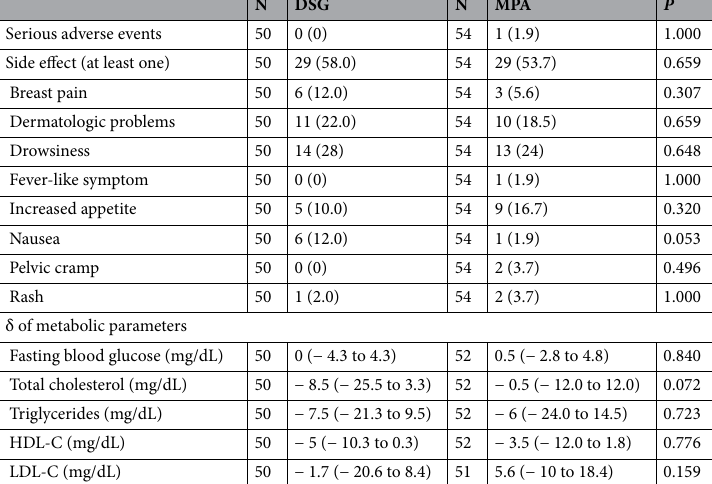
Table 3. Safety and tolerability. The incidence of serious adverse events and side effects are presented in number and percentage (in parentheses). The changes from baseline to month-6 of treatment (δ) of metabolic parameters are presented in median and interquartile range (in parentheses). Categorical data were compared using chi-square test or Fisher’s exact test. Continuous data were compared using Mann–Whitney U test. The serious adverse event included one case of colon cancer in the MPA group. Dermatologic problems included acne, pigmentation, or oily skin. DSG desogestrel, MPA medroxyprogesterone acetate, HDL-C high-density lipoprotein cholesterol, LDL-C low-density lipoprotein